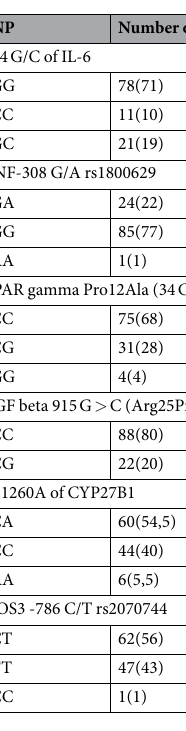
Table 2. Profiles of genetic biomarkers in HF patients. ABBREVIATIONS: SNP, single nucleotide polymorphism; IL-6, interleukin 6; TNF alpha, tumor necrosis factor alpha; PPAR gamma,